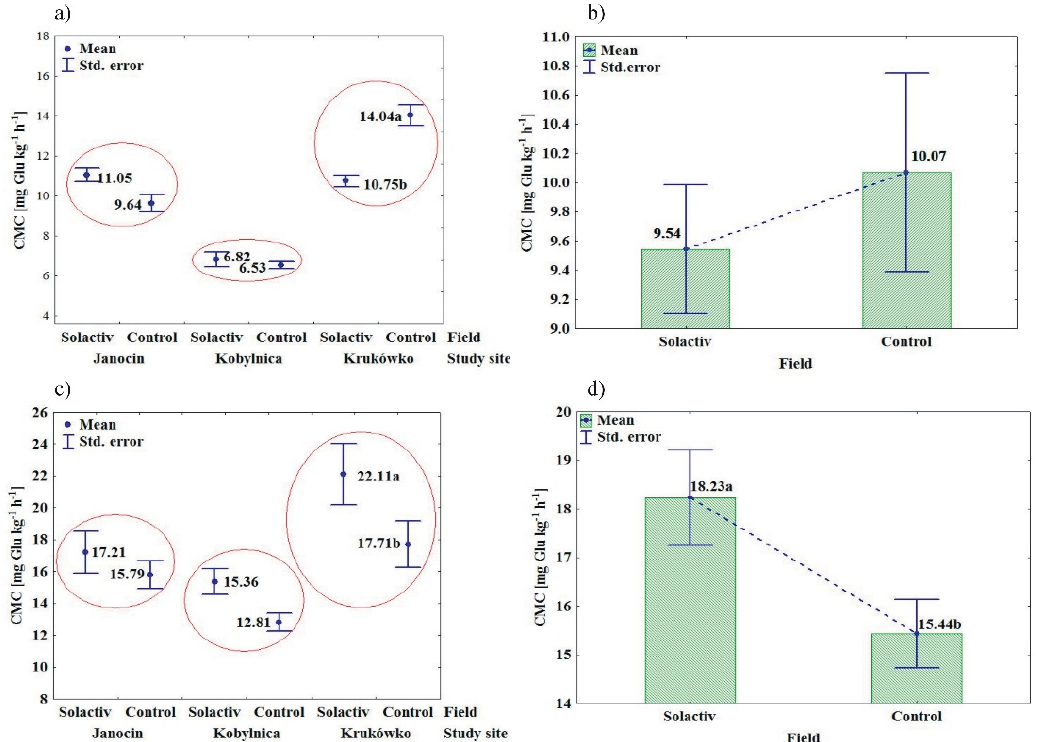
Figure 3. CMC-celulase activity as a ff ected by the tested conditioner. ( a , b ) I sampling (sampling before the maize was sown, n = 10); ( c , d ) II sampling (after the maize was harvested, n = 10); ( b , d ) the mean for all study sites ( n = 30). Data were analyzed using one-way ANOVA. Mean values for the conditioner and control followed by di ff erent letters are significantly di ff erent at p ≤ 0.05 according to Tukey’s HSD Test. The lack of letters indicates the lack of significance between means.